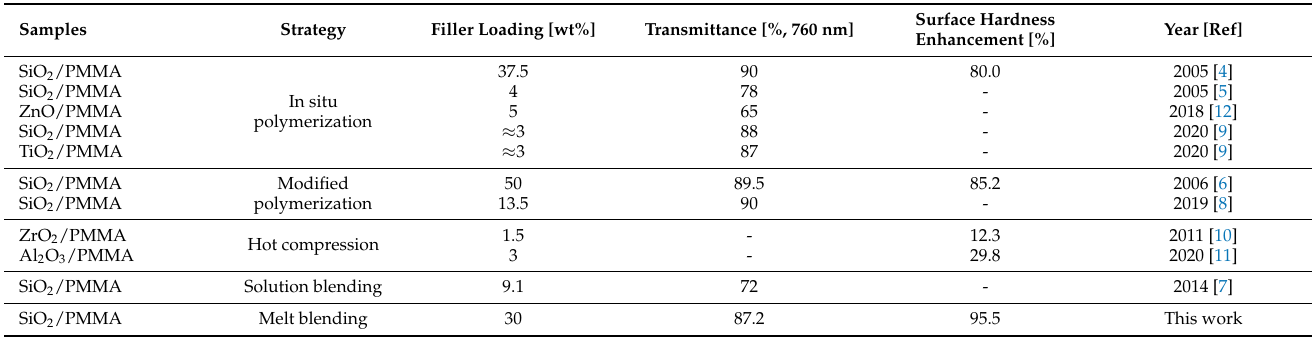
Table 1. A comparison of the transmittance and surface hardness enhancement in PMMA-based composites with various nanoparticles.